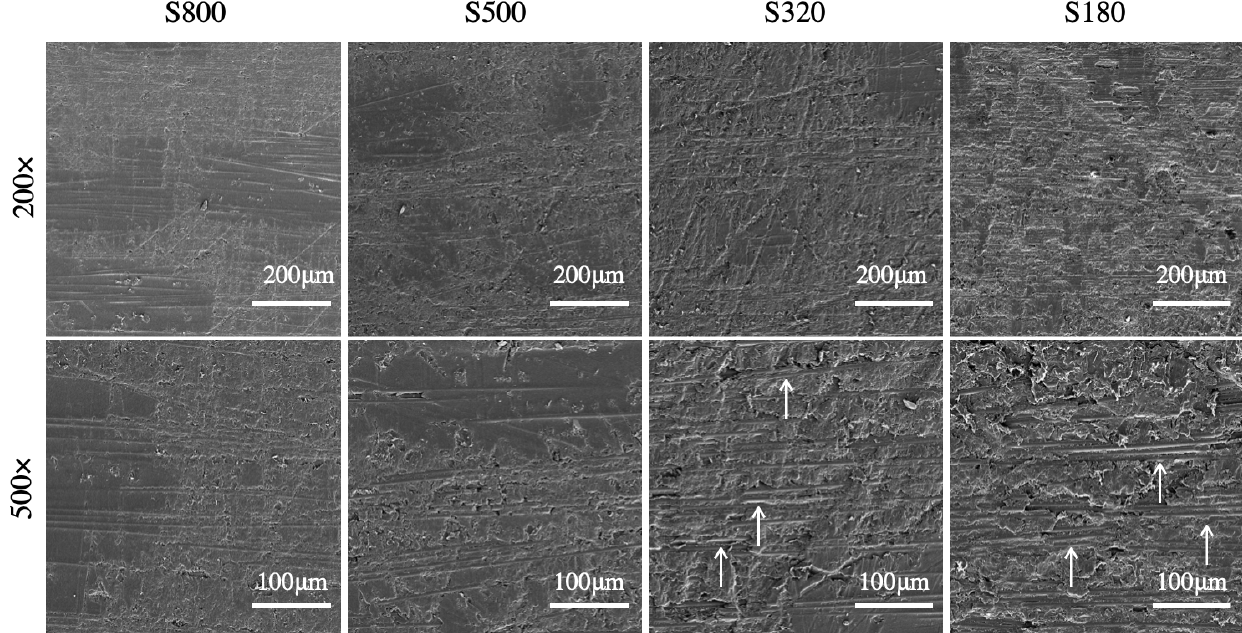
Figure 5. Scanning electron microscopy (SEM) images of CFRP surfaces sanded with silicon carbide papers of various grit